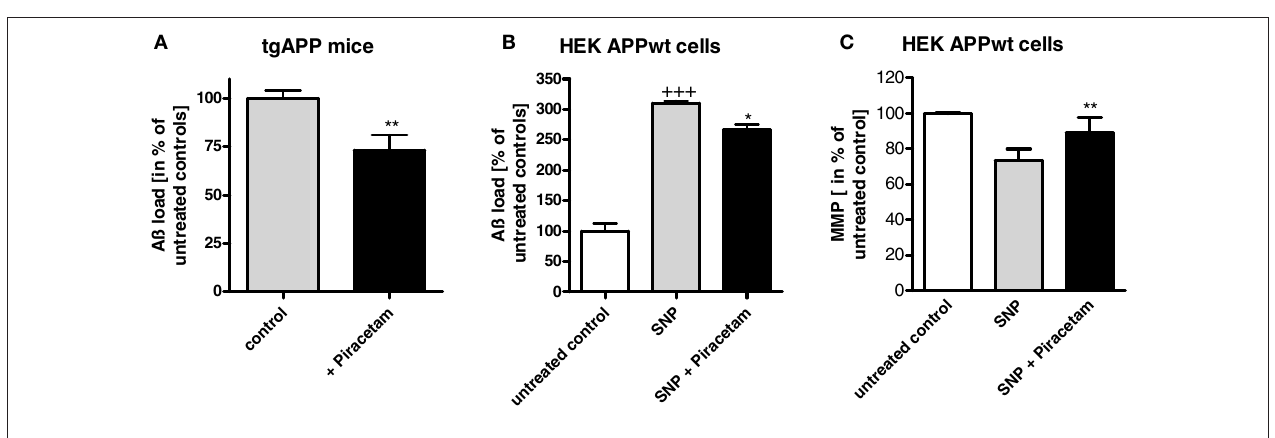
Figure 3 | Piracetam ameliorates elevated A β production following mitochondrial dysfunction. (A) Normalized A β levels were quantified in brain homogenates from non-tg littermate and tgAPP mice (3 months old). ** p < 0.01 piracetam treated tgAPP vs. control tgAPP; student’s unpaired t -test. (B) Piracetam reduces nitrosative stress induced elevation of A β in APPwt HEK293 cells. Cells were preincubated for 24 h with piracetam (1 mM) and stressed for additional 24 h with SNP (0.5 mM). Data are expressed as mean ± SEM ( n = 3–4). +++ p < 0.001 APPwt HEK293 control cells vs. cells treated